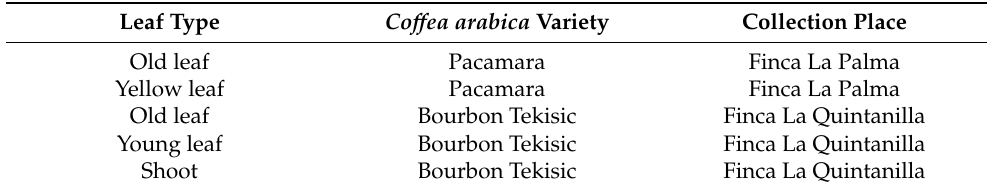
Table 1. Leaf types, their variety, and their collection place.